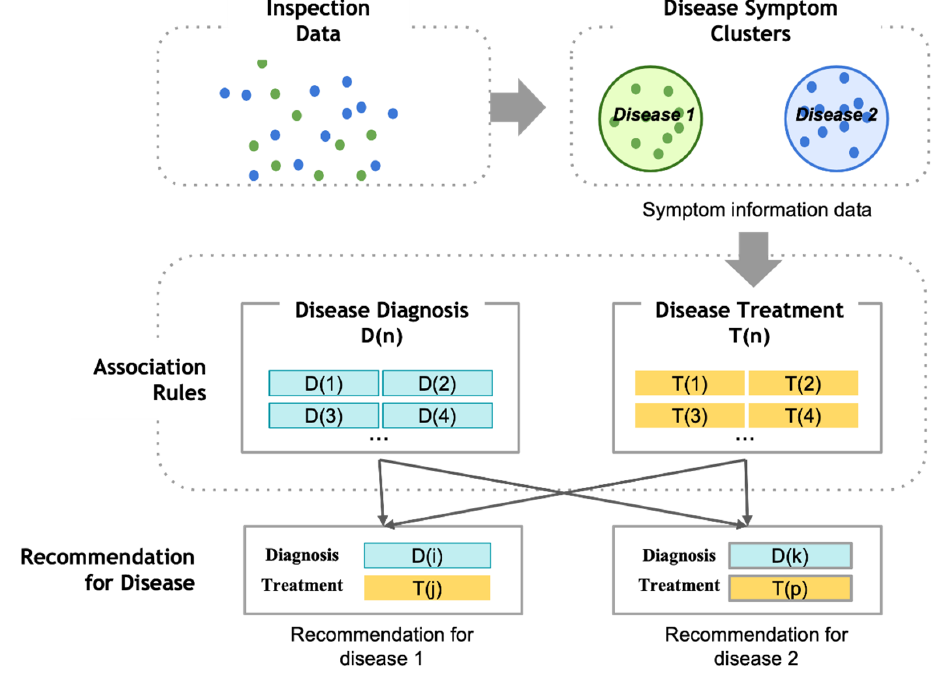
Figure 20. Workflow of disease diagnosis and treatment recommendation system.